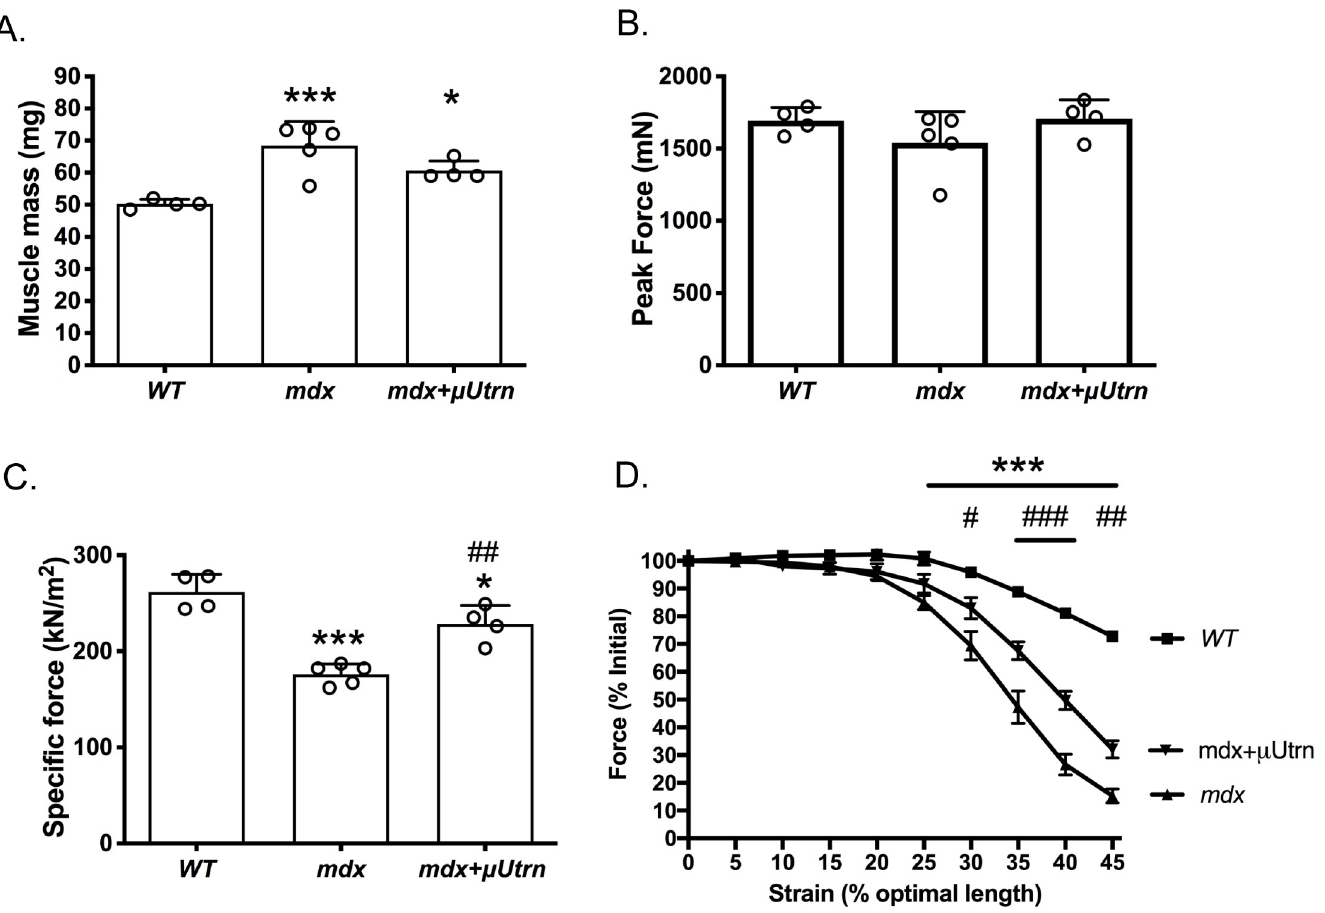
Fig 3. In situ physiological assessment of tibialis anterior muscles following vector treatment. (A.) Mean +/- S.D. tibialis anterior muscle mass. (B.) Mean +/- S.D. peak tetanic force production. (C.) Mean +/- S.D. specific force production. (D.) Peak tetanic force production after increasing strain. � P < 0.05 and ��� P < 0.001 compared to wild-type. # P < 0.05, ## P < 0.01 and ### P < 0.001 compared to mdx 4cv